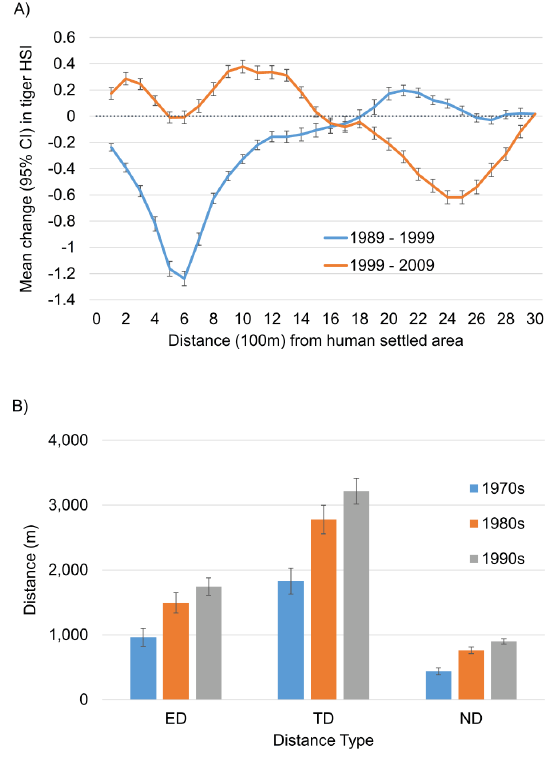
Fig. 3. (A) Change in Bengal tiger estimated habitat suitability index (HSI) in the 1990s and 2000s with distance from human settled areas inside the northern portion of Chitwan National Park, Nepal. Source: adapted from Carter et al. (2013 b ). (B) Temporal dynamics of distances of fuelwood collection sites from household locations. Bars indicate mean and SE. ED, Euclidean distance between a household and its fuelwood collection site; TD, length of the shortest road traveled by a household to the corresponding fuelwood site in road networks; ND, Euclidean distance from a fuelwood collection site to the location of the nearest household. Source: adapted from He et al.